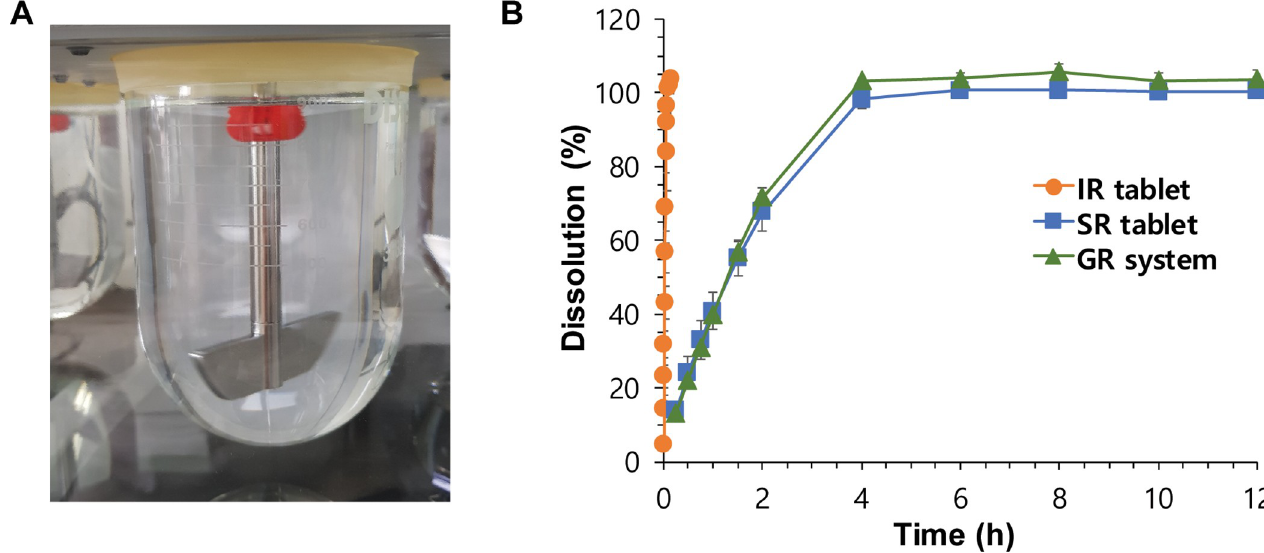
Fig 3. In vitro evaluation of the gastroretentive (GR) system. In vitro (A) floating ability and (B) dissolution profiles of the GR system compared to the immediate-release (IR) and sustained-release (SR) tablets. Data are presented mean ± SD (n = 4).